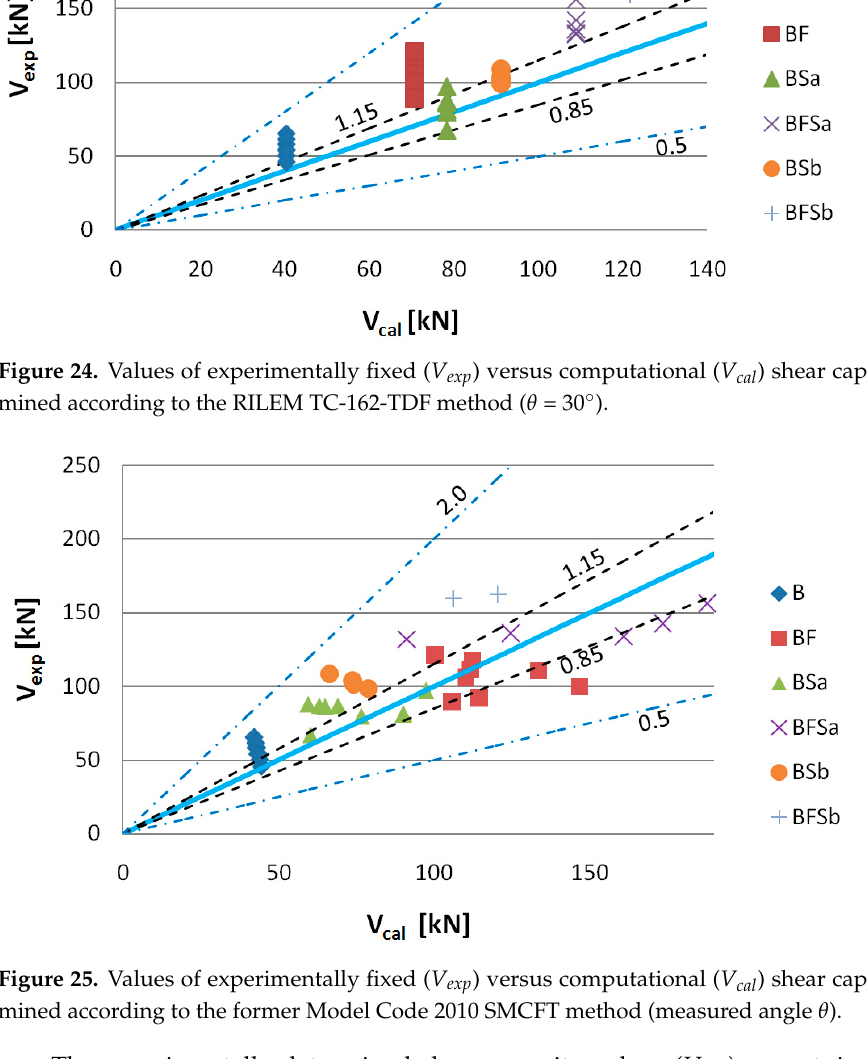
Figure 24. Values of experimentally fixed ( V exp ) versus computational ( V cal ) shear capacity deter- mined according to the RILEM TC-162-TDF method ( θ = 30°).